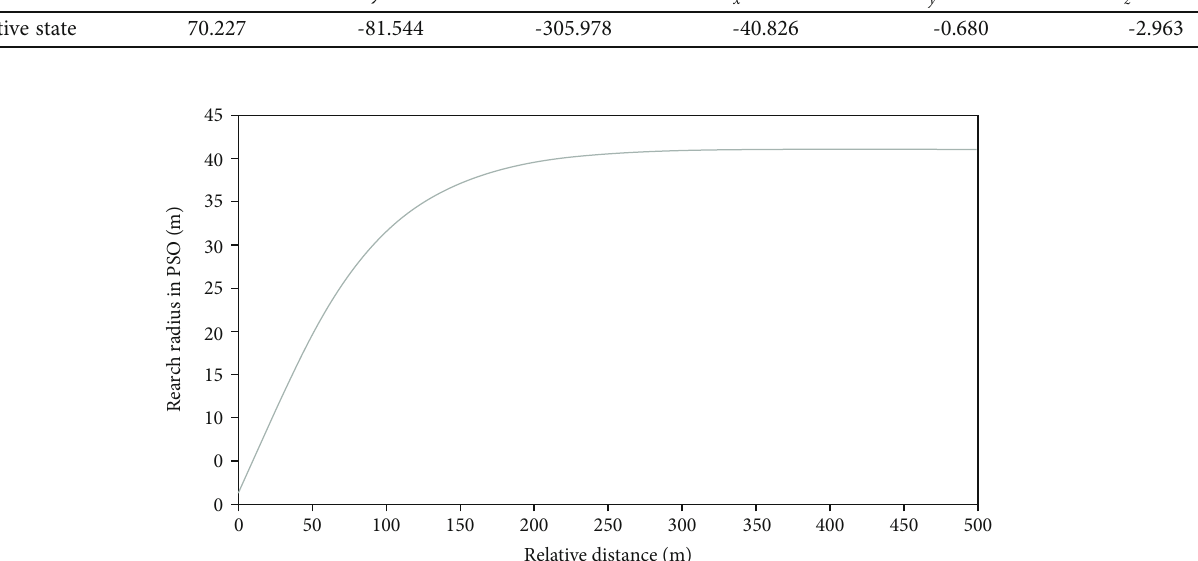
Figure 11: Relationship between the spacecraft-goal distance and the particle swarm search